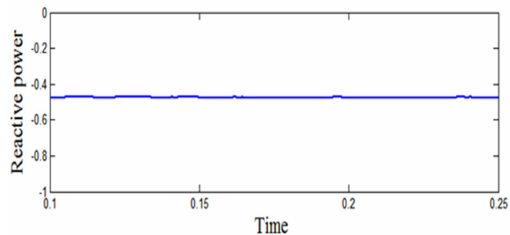
Figure 31. Real power demand from the load side.